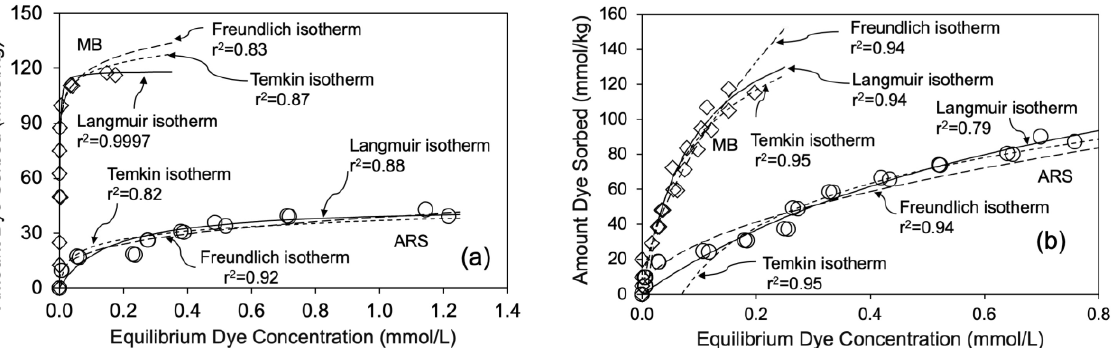
Figure 2. Sorption isotherms of MB (diamond) and ARS (circle) on the HNC from single ( a ) and binary ( b ) solutions. Table 1. Sorption parameters of ARS and MB on the HNC for the isotherm and kinetic studies.